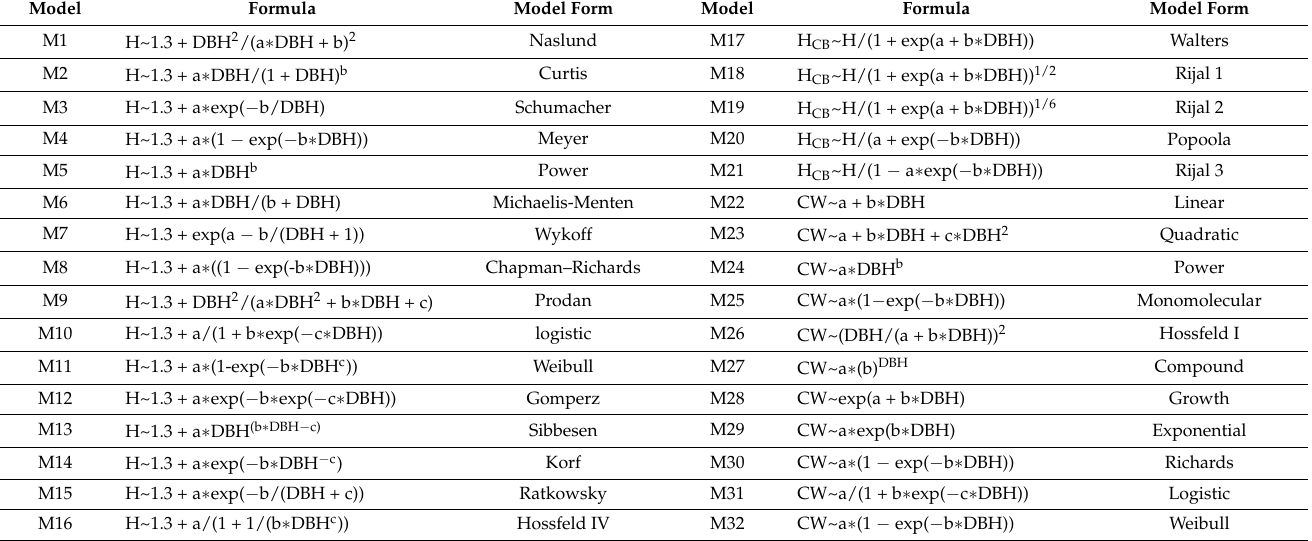
Table 2. Base model selection: H is the total tree height (m), DBH is the diameter at breast height (cm), H CB is the height-to-crown base (m), and CW is the crown width (m); a, b, and c are the parameters of the model. M1~M32 represents the formulae of the morphological characteristic